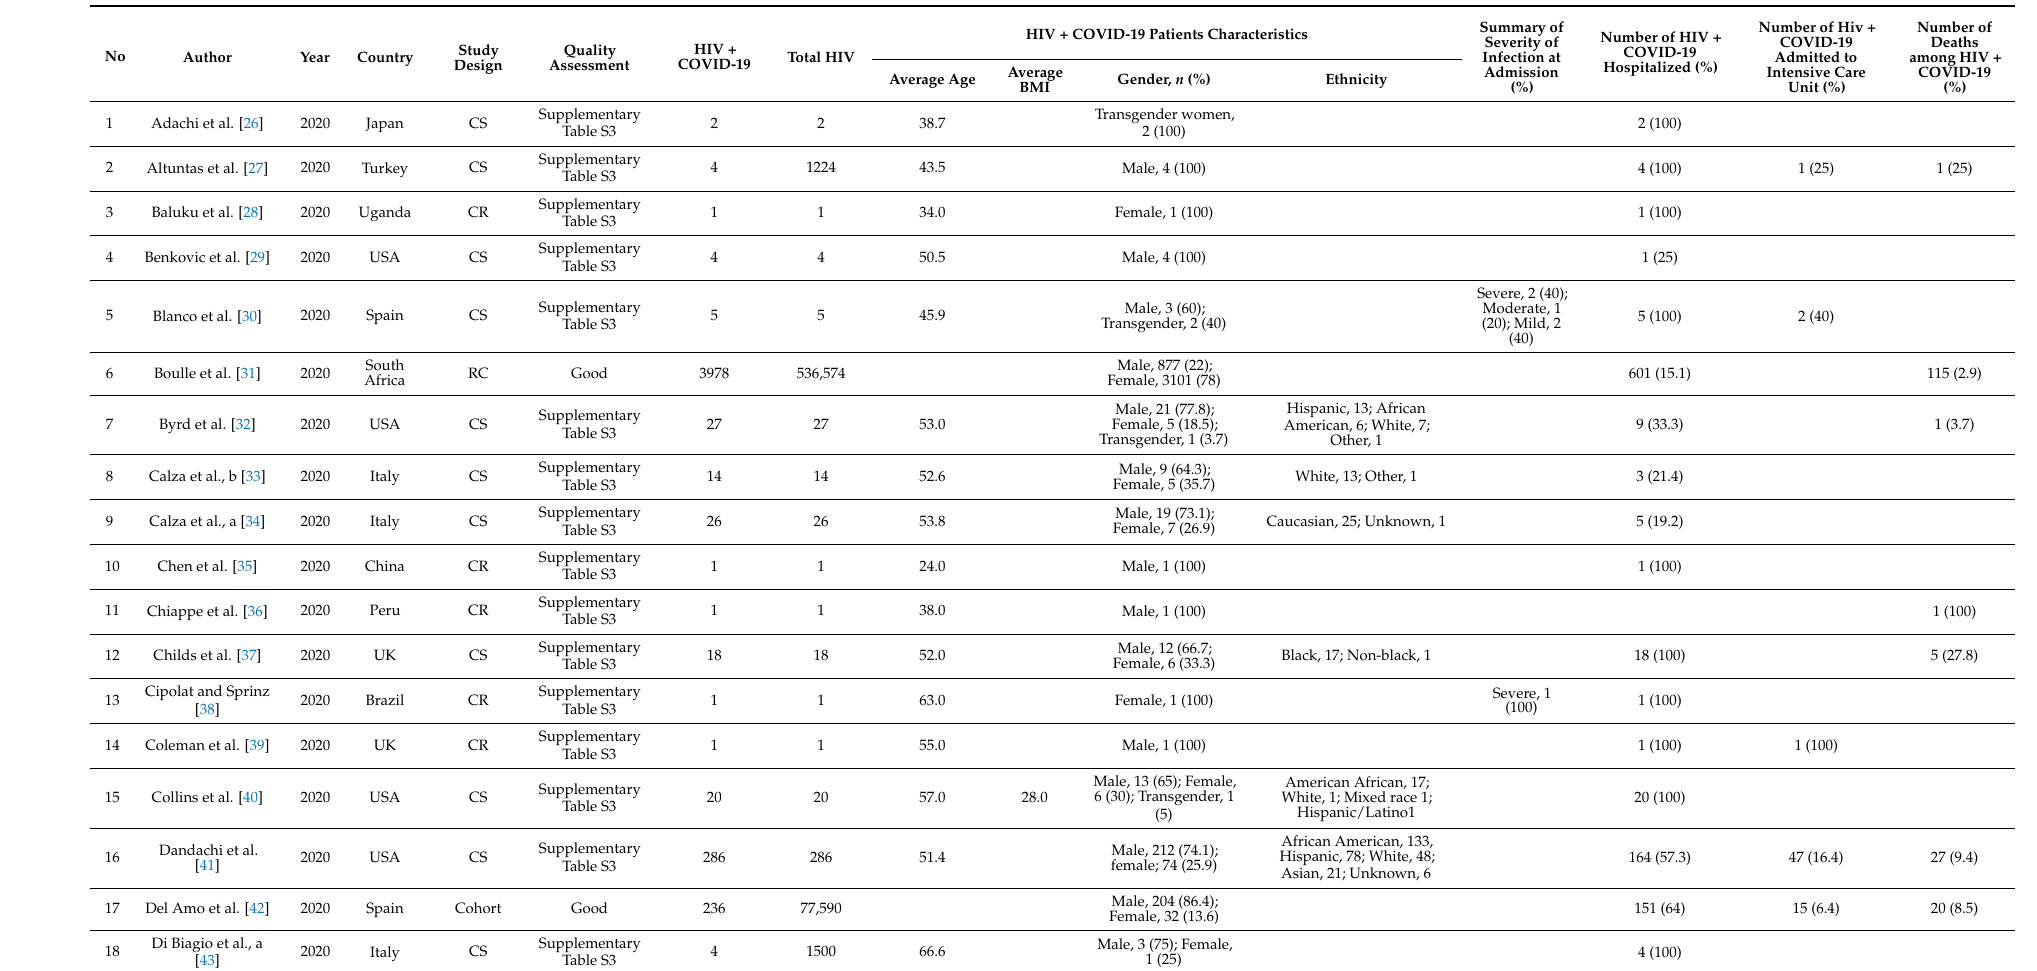
Table 1. Characteristics of the included